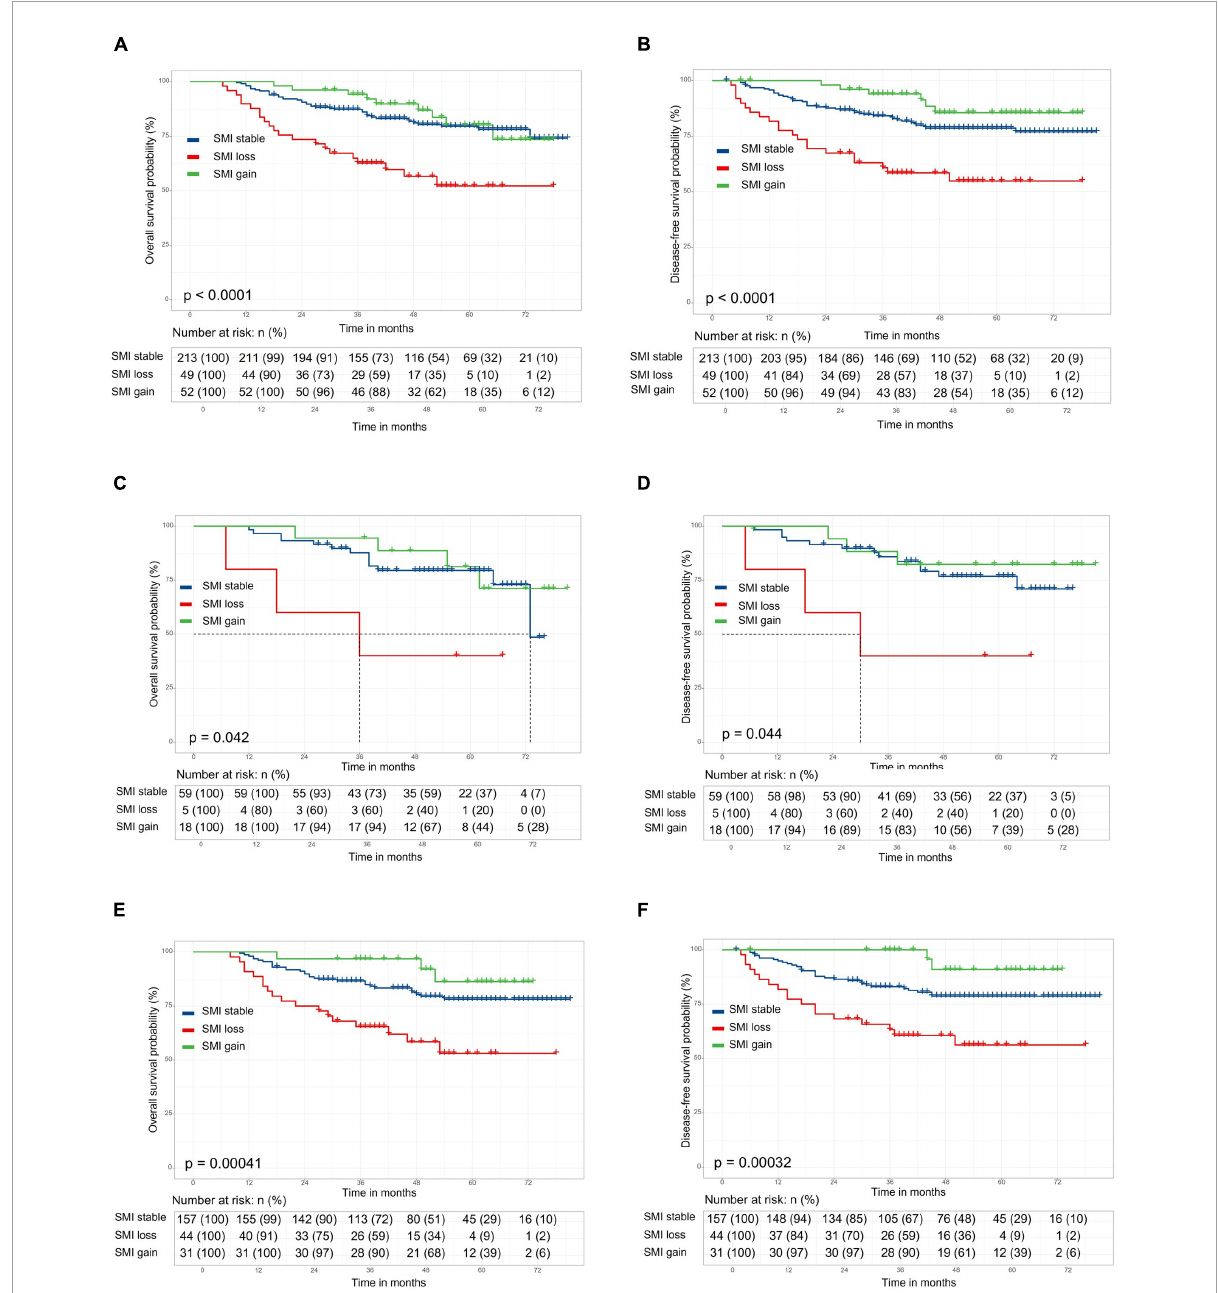
FIGURE2 Kaplan–Meier curve demonstrating overall survival and disease-free survival according to skeletal muscle index (SMI) change. The 5-year overall survival (OS) and disease-free survival (DFS) in stocktickerSMI loss, stocktickerSMI stable, and stocktickerSMI gain groups were 52.2, 79.5, and 80.1% [ (A) , p < 0.001] and 54.8, 78.5, and 85.5% [ (B) , p < 0.001], respectively. In a subgroup analysis, patients with stocktickerSMI loss had worse OS and stocktickerDFS in both the preoperative sarcopenia [ (C,D) and non-sarcopenia groups (E,F)